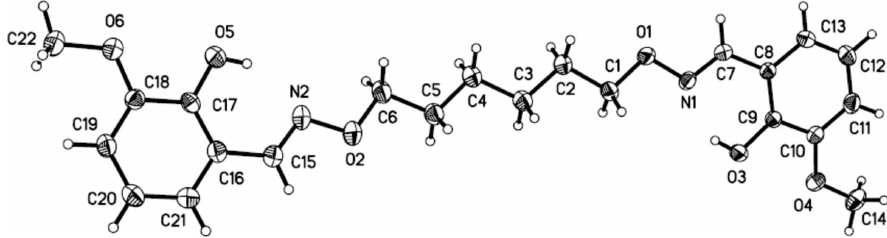
Figure 1 The molecule structure of (I) with atom numbering. Displacement ellipsoids for non-hydrogen atoms are drawn at the 30% probability